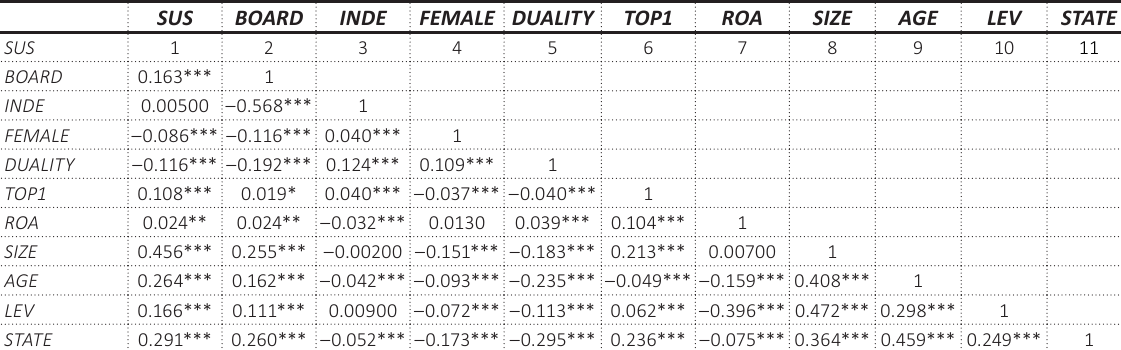
Source: Developed by the authors.